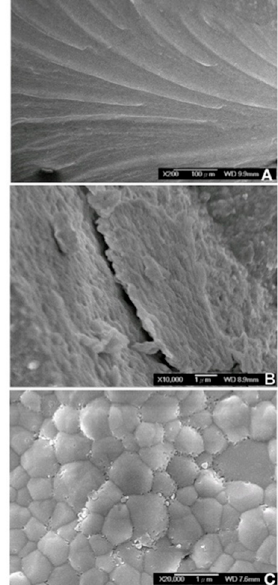
Figure 7. Scanning electron microscope images showing fracture conditions from broken segments.